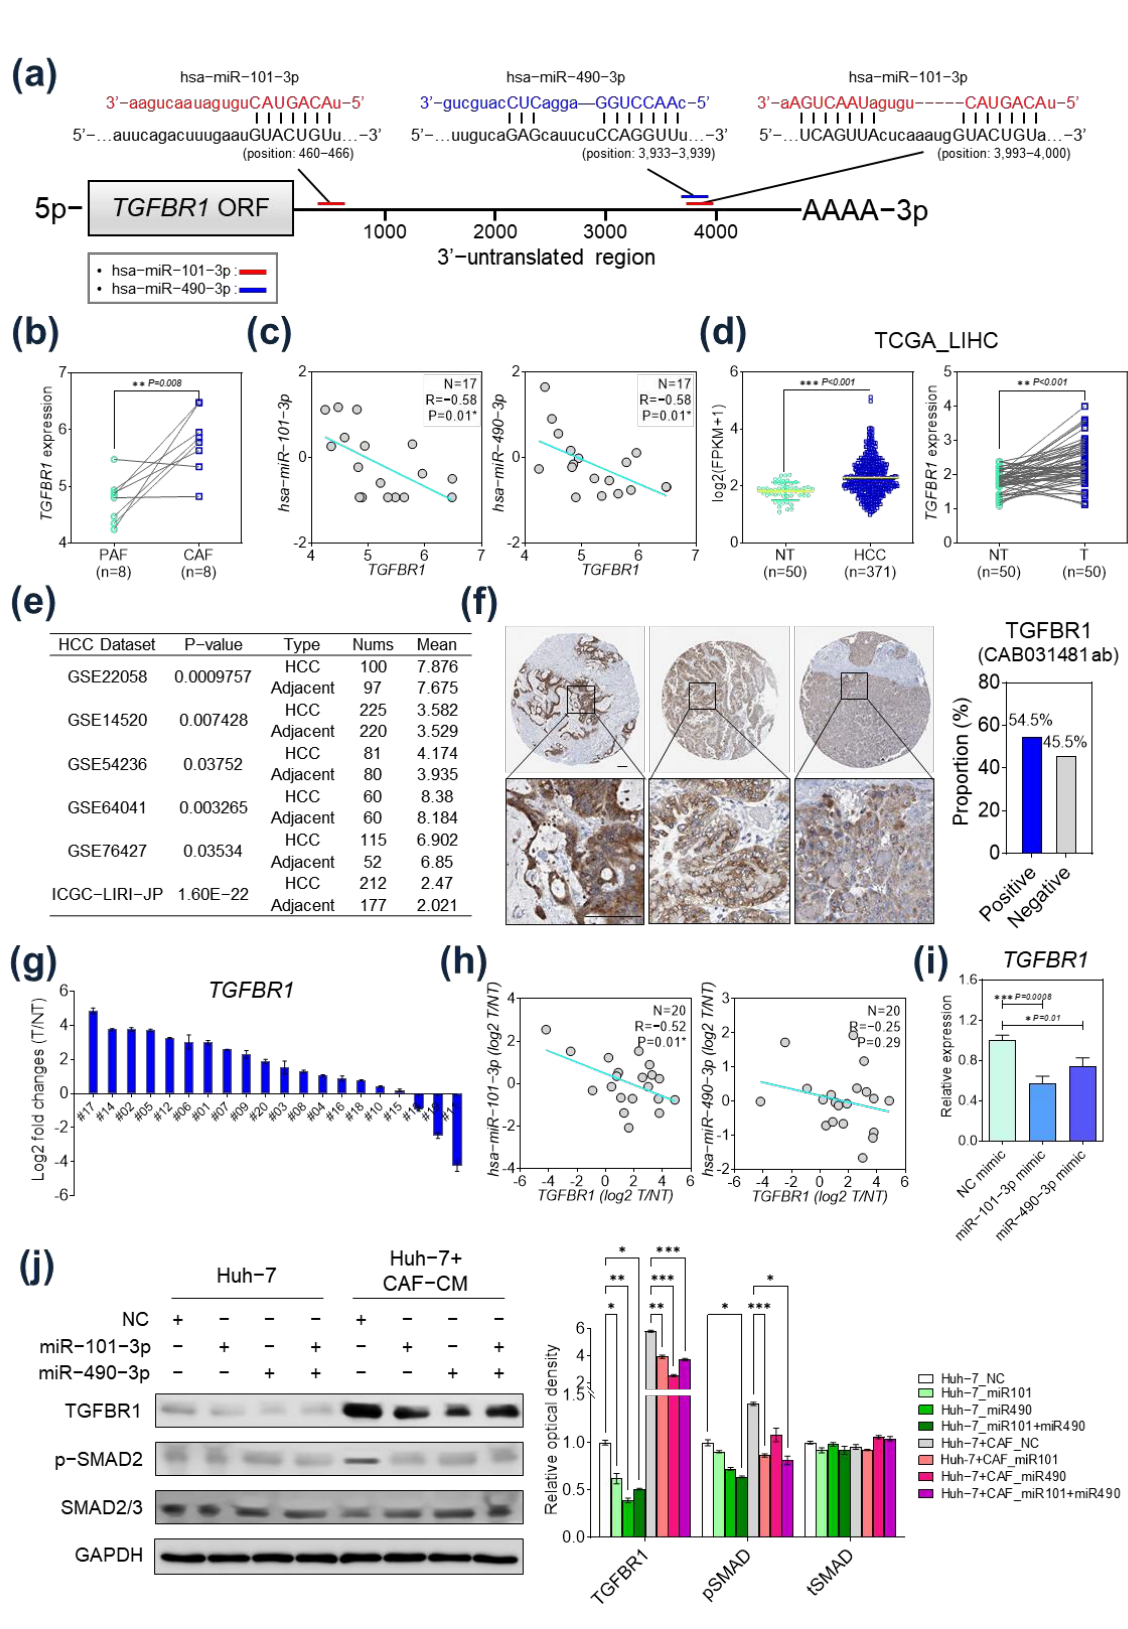
Figure 4. TGFBR1 expression was negatively regulated by hsa-miR-101-3p and hsa-miR-490-3p in hepatocellular carcinoma (HCC). ( a ) The target sites of h sa -miR-101-3p and h sa -miR-490-3p in 3′ -UTR of TGFBR1 are shown as a schematic representation. ( b ) TGFBR1 expression in cancer-associ- ated fibroblasts (CAFs) and para-cancer fibroblasts (PAFs). TGFBR1 expression was significantly